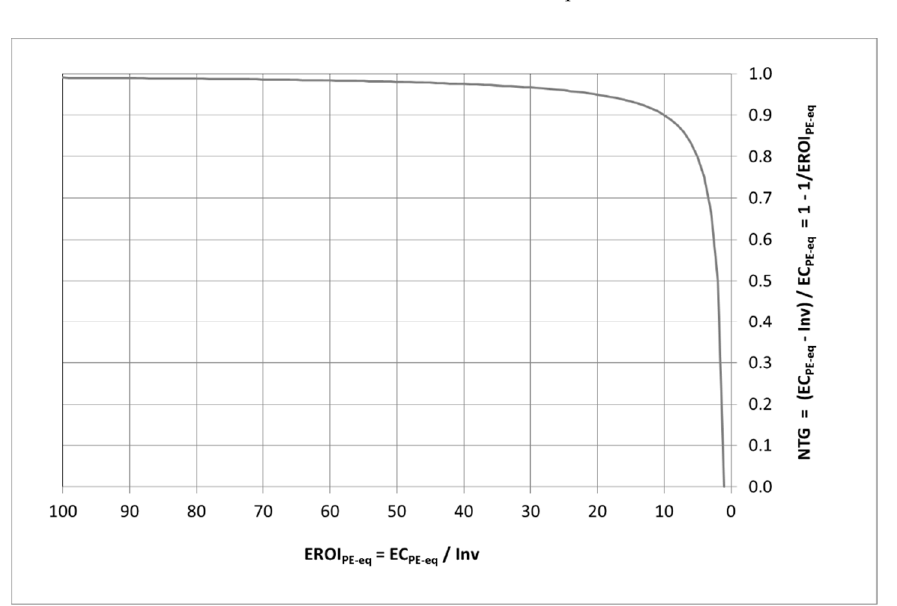
Figure 6. “Net energy cliff” diagram displaying the relation between Energy Return on Investment (EROI PE-eq ) and Net-to-Gross ratio (NTG).